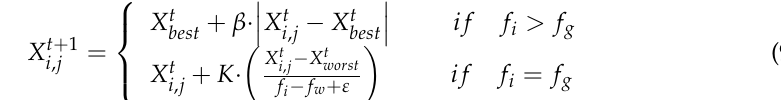
Figure 3 represents the iterative flow chart of